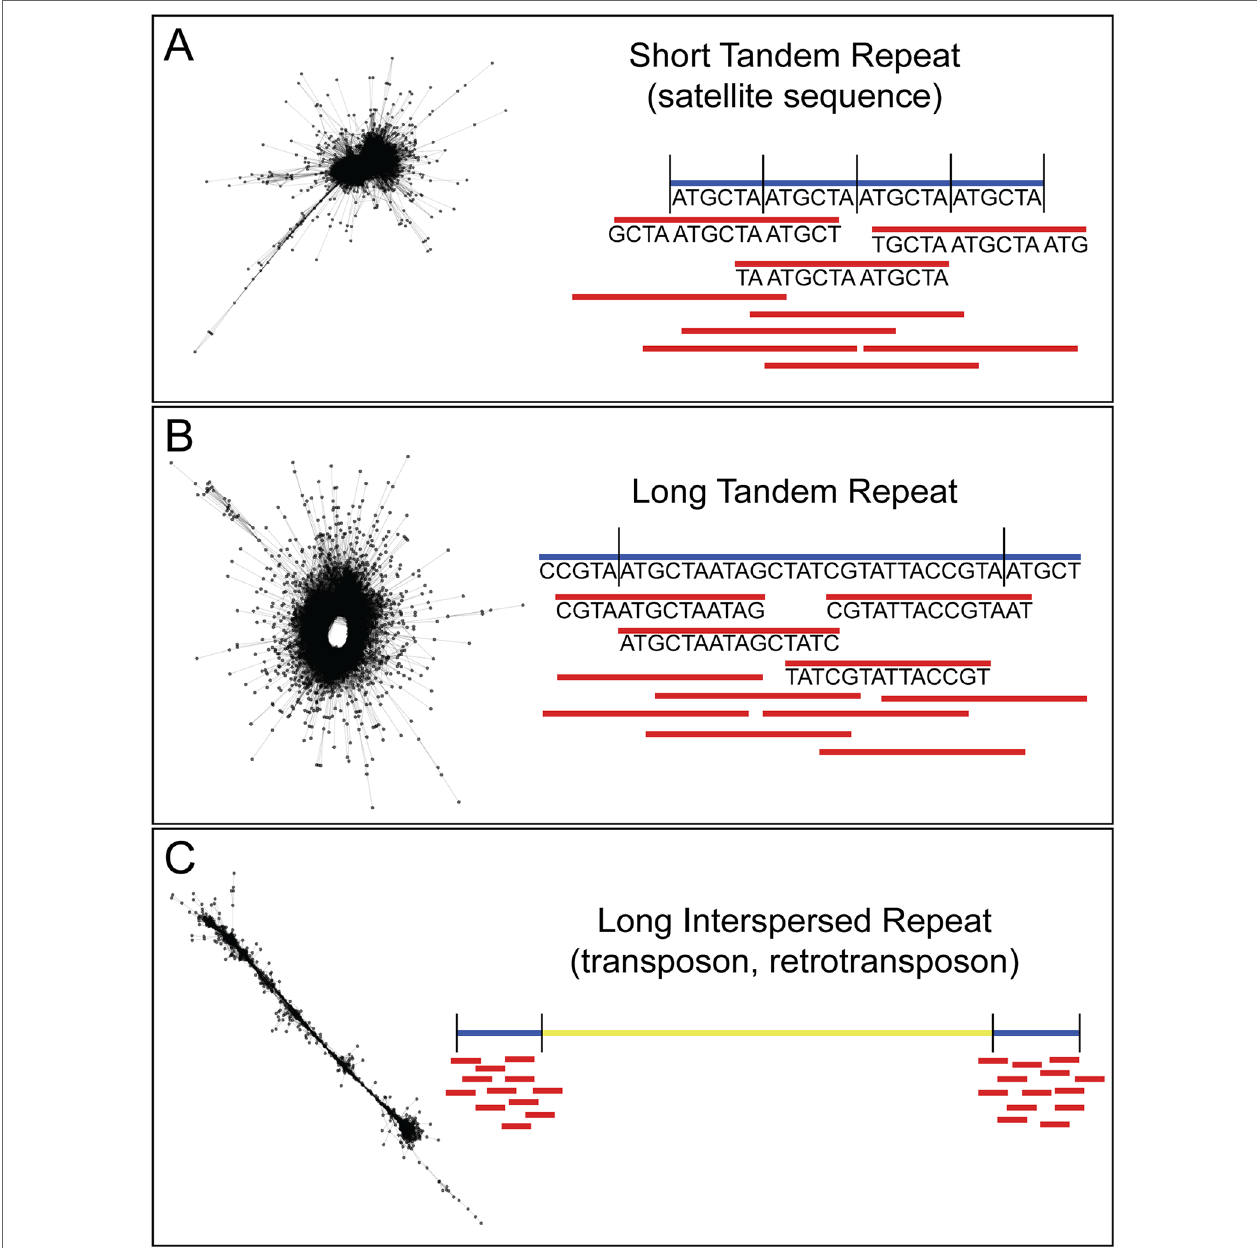
FIGURE 1 | Description of RepeatExplorer cluster output. (A) Short tandem repeats, including many satellite sequences, form characteristic “star burst”-type clusters. Because they are tandem, and such repeats are of similar size or shorter than the length of an individual sequence read, a very high percentage of reads within the cluster meet the RepeatExplorer-defined criteria for pair formation. This results in each read successfully pairing with a very high percentage of the other reads assigned to the cluster. Because nearly all of the reads within the cluster are paired with nearly all of the other reads within this same cluster, a compact network of very short edges forms between reads. This in turn generates a very dense cluster with a core of paired reads possessing nearly identical sequences. If of sufficient length for assay design, the consensus sequences for these clusters make ideal diagnostic targets, as they contain the greatest number of repeats per read. (B) Long tandem repeats characteristically result in “doughnut”-like clusters. In such clusters, neighboring reads within the underlying scaffold meet the criteria for pair formation. However, because the length of the repeat monomers generating these clusters is longer, reads may be significantly shorter than the monomer itself. This results in many reads within the cluster that do not meet the criteria for pair formation as they map to different regions of the same monomer unit. Yet because they are tandemly arranged, reads spanning a repeat-repeat junction will meet the pair formation criteria, closing the sequence “loop” and resulting in a “doughnut”-shaped cluster. (C) Long interspersed repeats, such as transposable elements form characteristic “line”-type clusters. While reads neighboring each other in the underlying scaffold meet the criteria for pair formation, the extended length of a repeat monomer means that distant reads within a single monomer will not meet this threshold. This results in similar pairings to those seen in clusters generated from long tandem repeats. However, because these elements are interspersed, reads do not span repeat-repeat junctions, so a “loop” is not formed, and clusters attain a linear